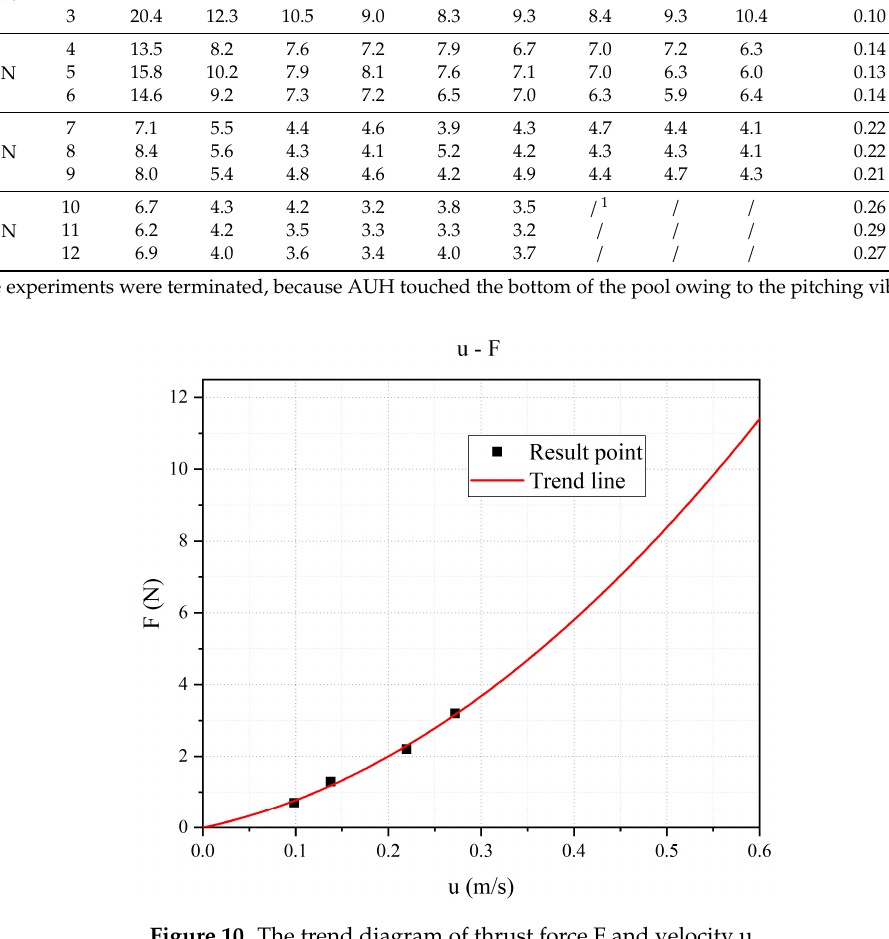
Figure 10. The trend diagram of thrust force F and velocity u.